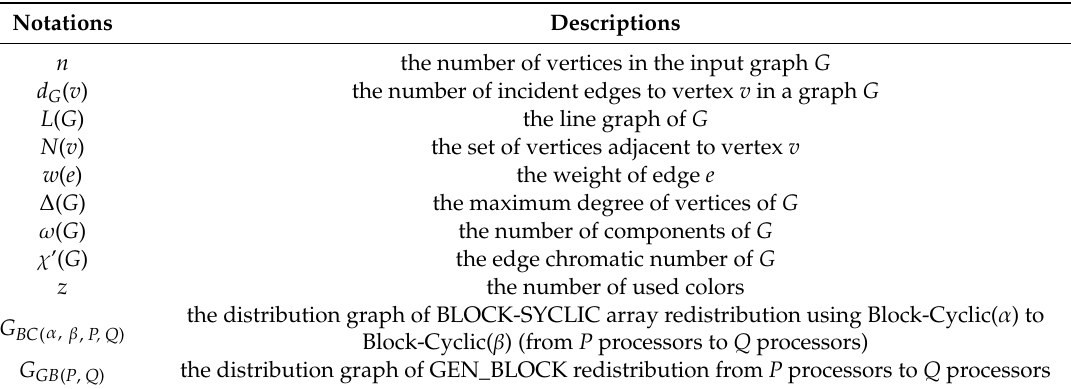
Table 1. Notations used in this work.